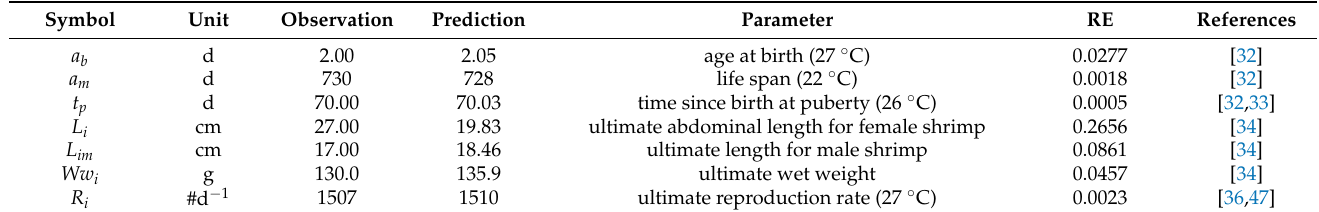
Table 2. List of zero-variate data used to estimate parameters of the kuruma shrimp DEB model. References of observed data and relative error (RE) are specified. The average temperature at which parameters were measured is provided.